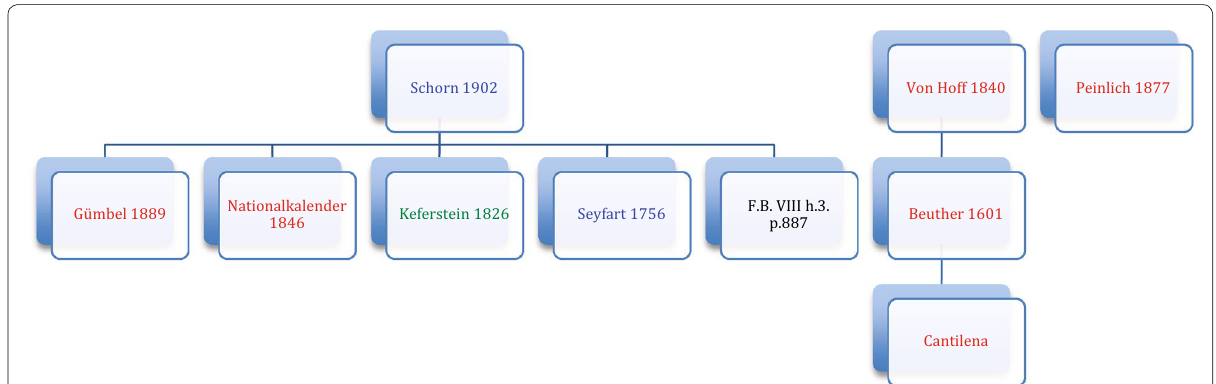
Fig. 1 Family tree of the earthquake on 1st November 1571. At first view one can imagine inconsistency. After a thorough verification of the information, the “earthquake” turned out to be a fake. The information was mainly confused with the big flood in the Netherlands on 1st November 1570, but also with other earthquakes. red 1st November 1571, green 23rd/24th/27th March 1571, blue 1571, black does not